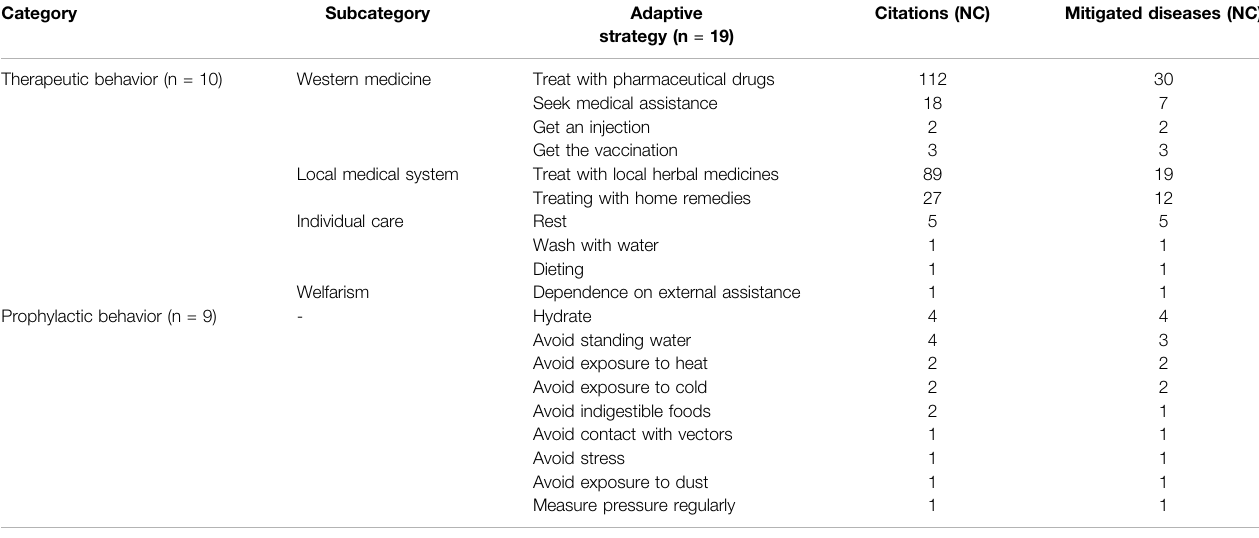
TABLE 4 | Adaptive strategies used to mitigate diseases perceived by farmers living in the Catimbau NAPAR, Pernambuco State, Northeastern Brazil.